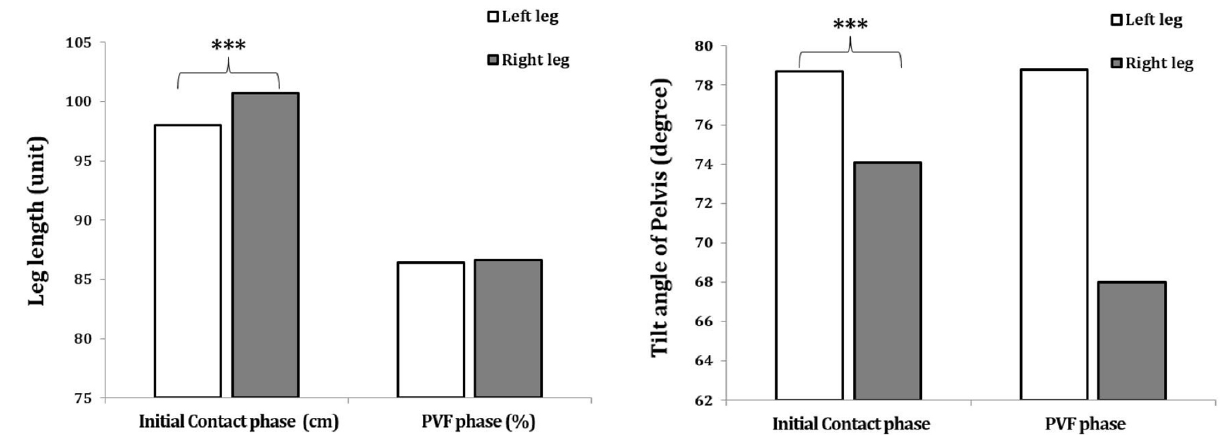
Fig. 3. Result of the leg length (left), and tilt angle of pelvis center (right) according to the landing leg. *** p < 0.001.